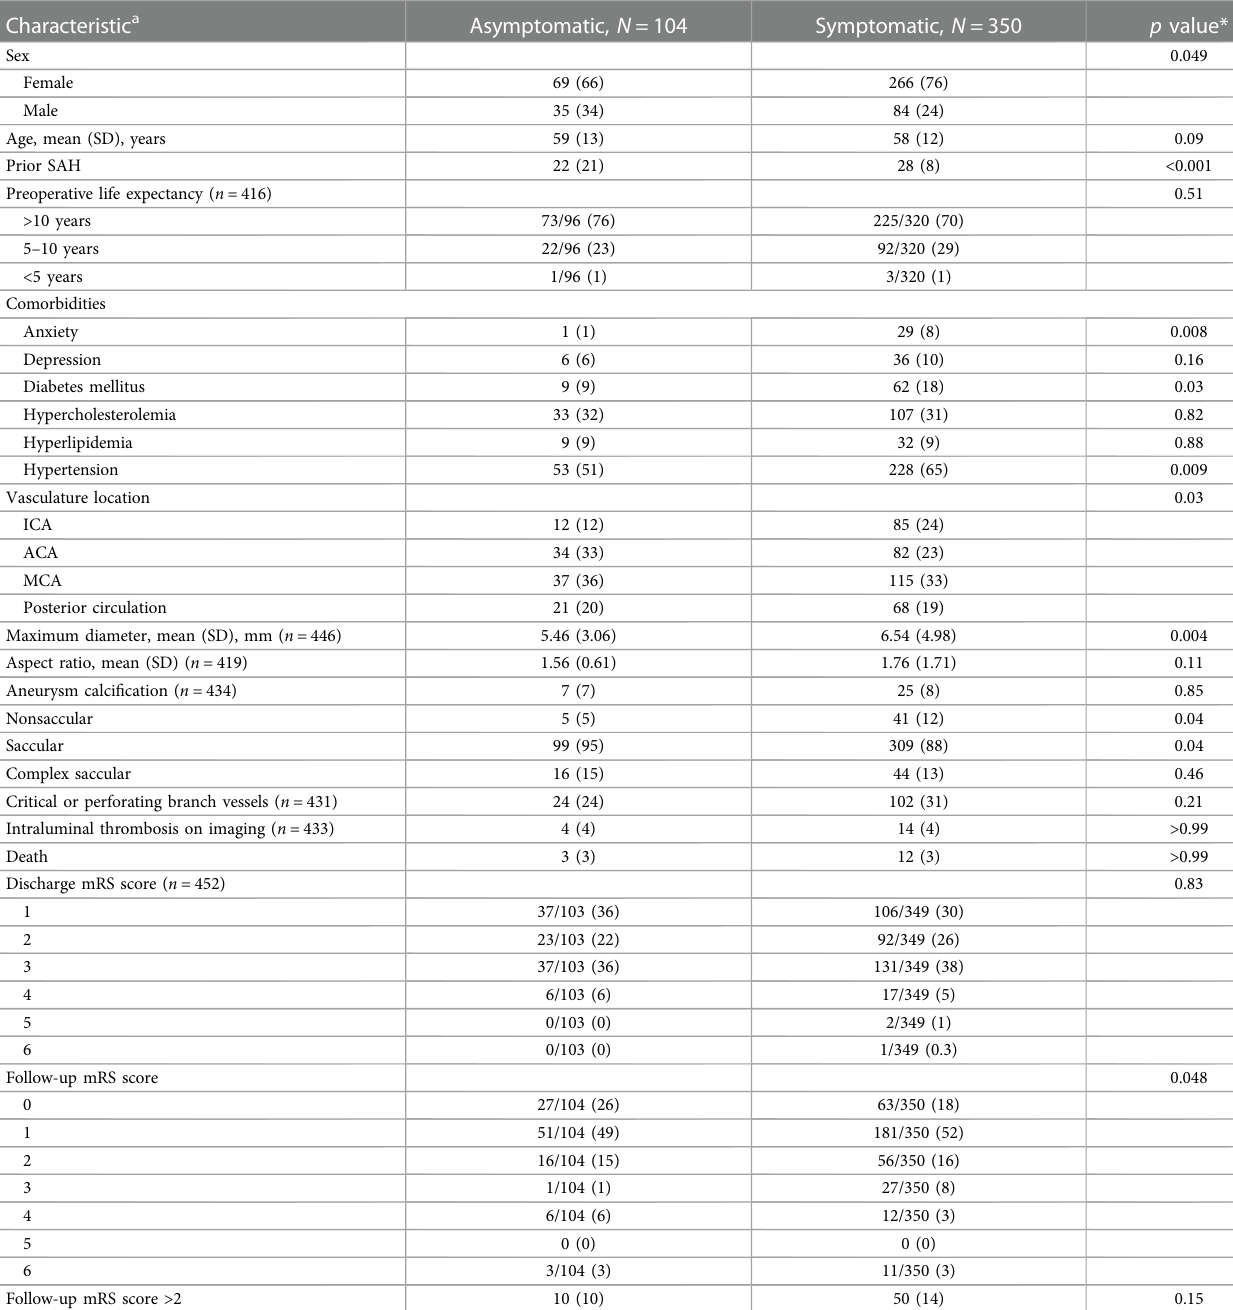
TABLE 4 Comparison of demographic and clinical characteristics of 104 asymptomatic and 350 symptomatic patients with unruptured intracranial aneurysms. Characteristic